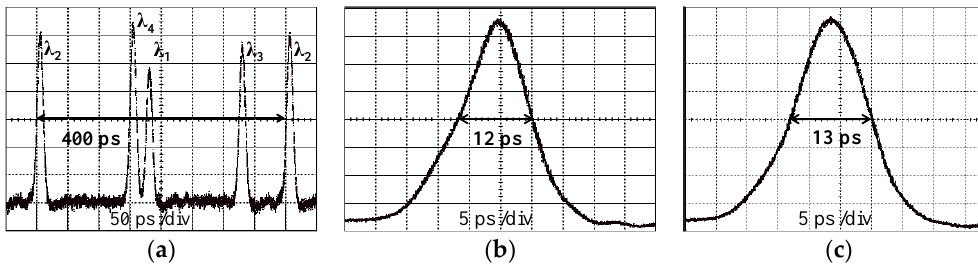
Figure 3. ( a ) OCDMA encoder output showing a user-1 (1- λ 2 , 21- λ 4 , 24- λ 1 , 39- λ 3 ) 2D-WH/TS OCDMA code 400 ps long as seen by a bandwidth limited oscilloscope with 64 GHz optical sampling head; ( b ) Recovered OCDMA autocorrelation by the OCDMA decoder at the room temperature T = 20 ◦ C (FWHM width = 12 ps); and, ( c ) at T = 50 ◦ C (FWHM width = 13 ps), respectively.